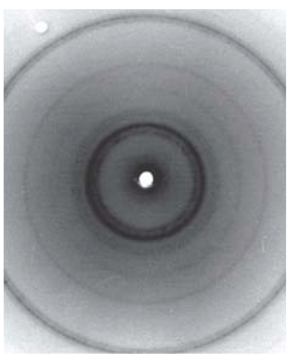
Figure 9. Pole figure obtained from alloy 3, whose specimen was taken from a cylinder liner. This pole figure shows that the specimen has a typical low intensity aluminium deformation texture.